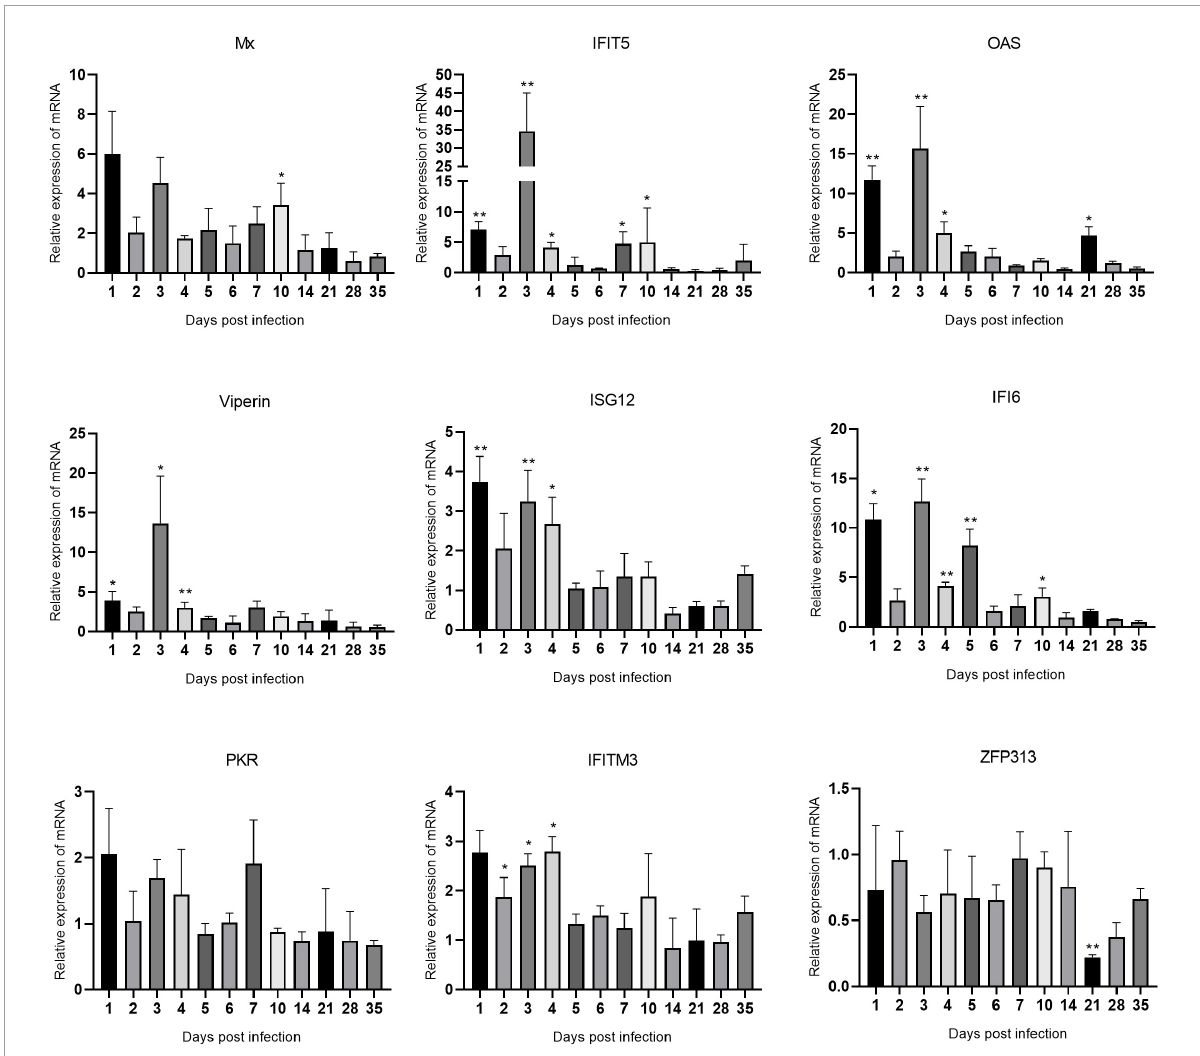
FIGURE6 Changes in ISG transcription levels in the bursa of Fabricius after ARV infection. ARV strain S1133 (10 4 TCID 50 /0.1 ml) was used to infect chickens through the footpad. At 1, 2, 3, 4, 5, 6, 7, 10, 14, 21, 28, and 35 days after infection (dpi), three chickens were randomly collected from each group, and changes in ISG mRNA levels in the bursa of Fabricius were measured by real-time quantitative PCR. The data are the mean ± SD of three independent experiments. Asterisks indicate significant differences (* P < 0.05, ** P <